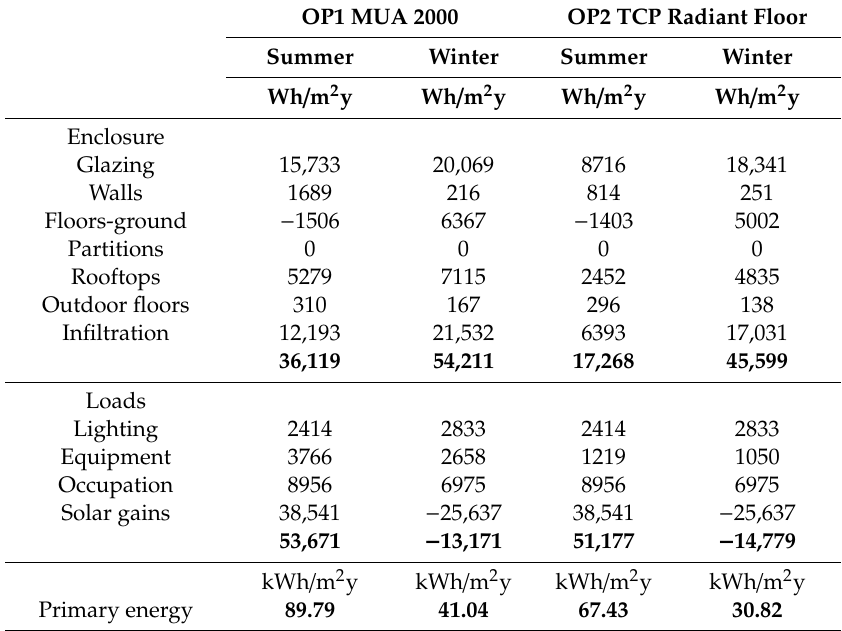
Table 2. Calculation of energy demands. Current state, radiant floor OP2 and radiating walls